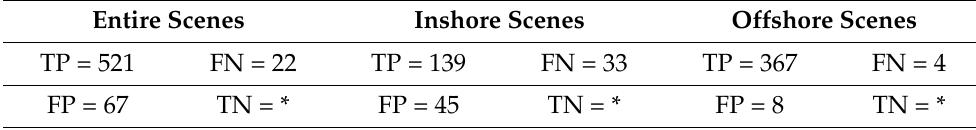
Table 5. The confusion matrix of the SSDD dataset in the entire, inshore and offshore